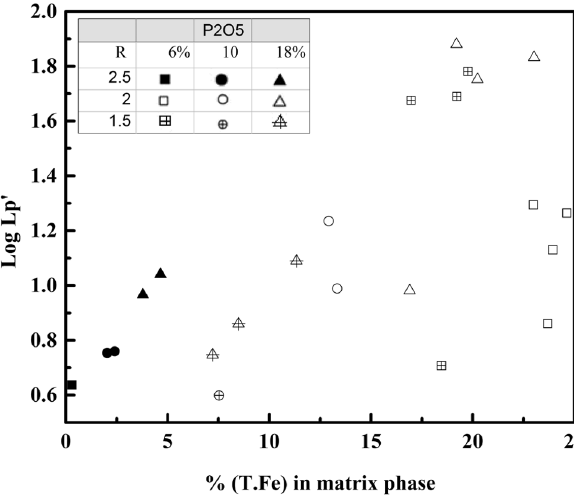
Fig. 7: The effect that slag composition and basicity on Lp ′ of the CaO-SiO 2 -Fe t O- P 2 O 5 slag system